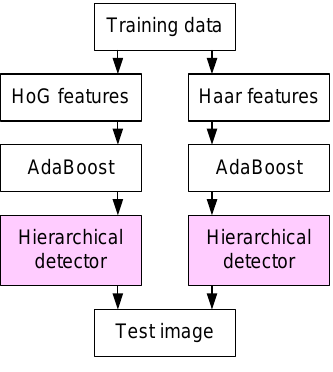
Figure 1: Experimental setting